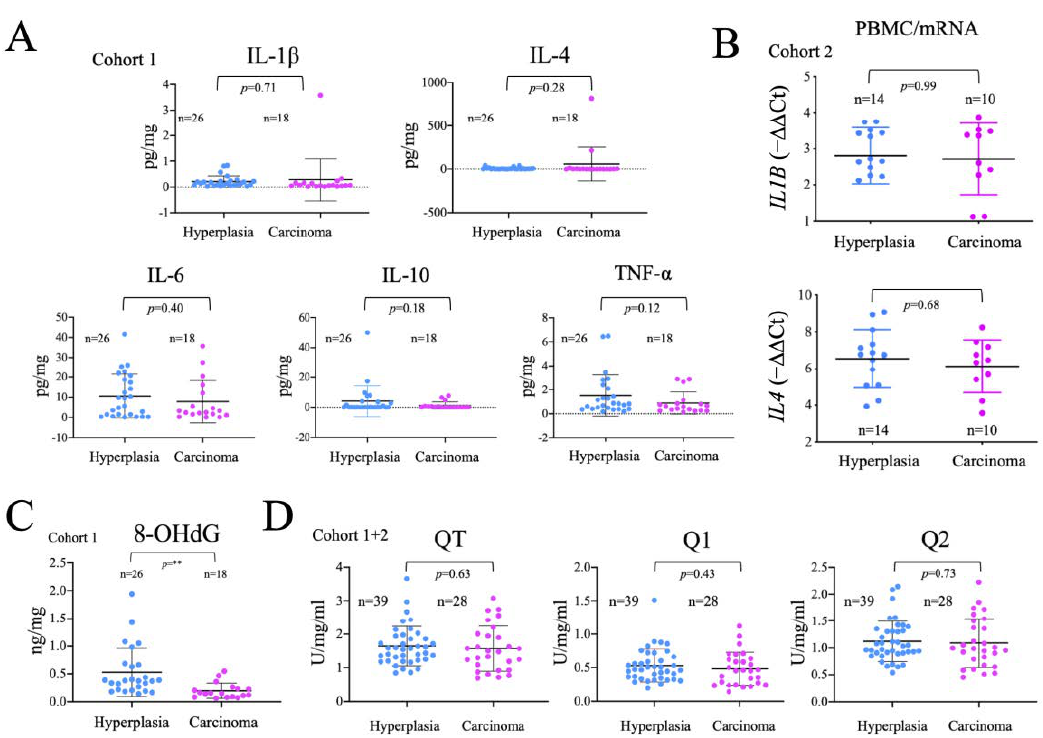
Figure 4. Absence of significant differences in inflammation and antioxidant capacity between patients with cancer and hyperplasia. ( A ) Analysis of inflammatory molecules in plasma samples (IL-1ß, IL-4, IL-6, IL-10, TNF α ). ( B ) qRT-PCR gene expression analysis of IL1B and IL4 in PBMCs ( C ) ELISA determination of 8-OHdG in plasma samples. ( D ) Electrochemical analysis of total (QT), fast (Q1) and slow (Q2) antioxidant capacity in plasma samples. Data are mean ± standard deviation (SD). **, p ≤ 0.01.